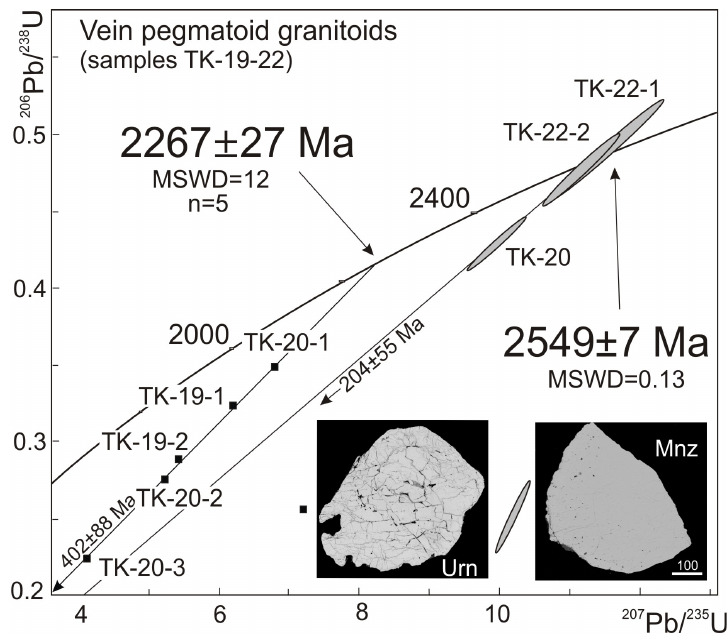
Figure 3. U-Pb isotope data for monazite and uraninite from vein pegmatoid granitoids of the Dikoe occurrence of the Litsa area.